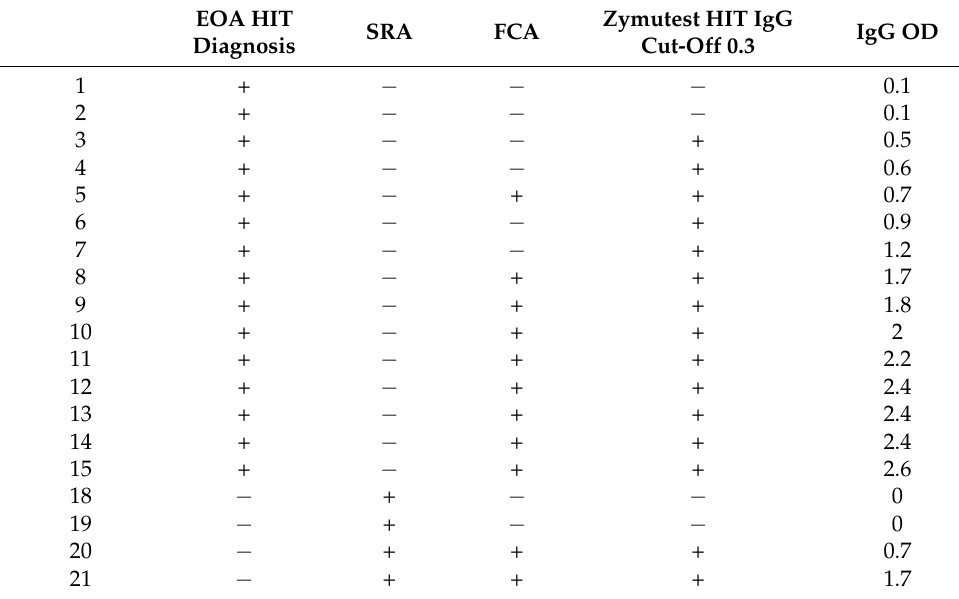
Table 2. False-negative and false-positive SRA